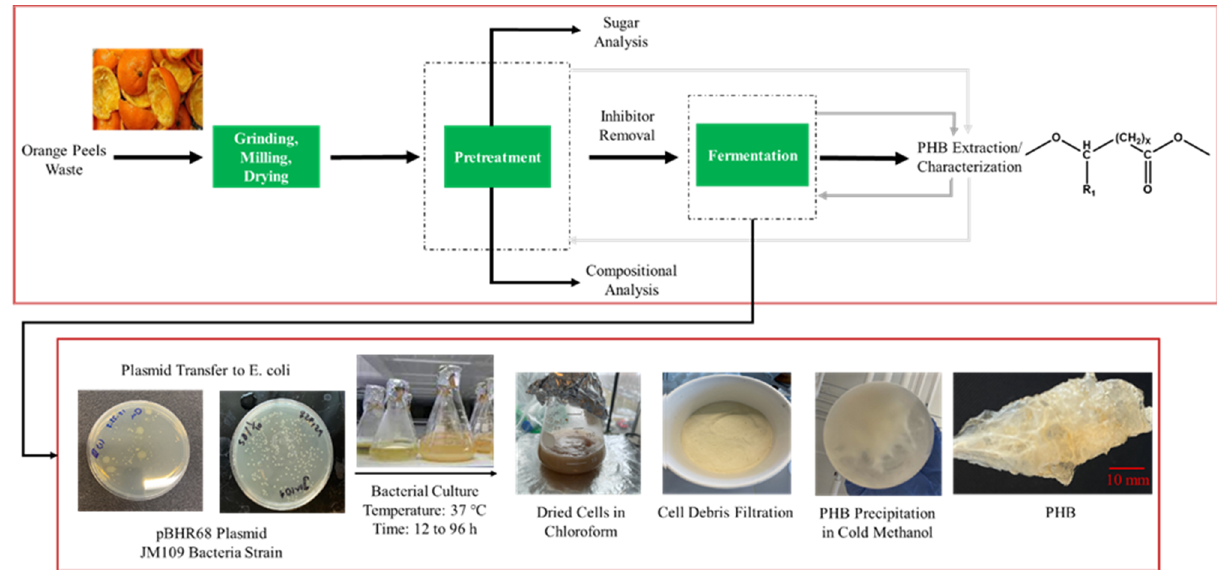
Figure 1. Schematic diagram for the experimental procedure of orange peel waste treatment, PHB production, and extraction.